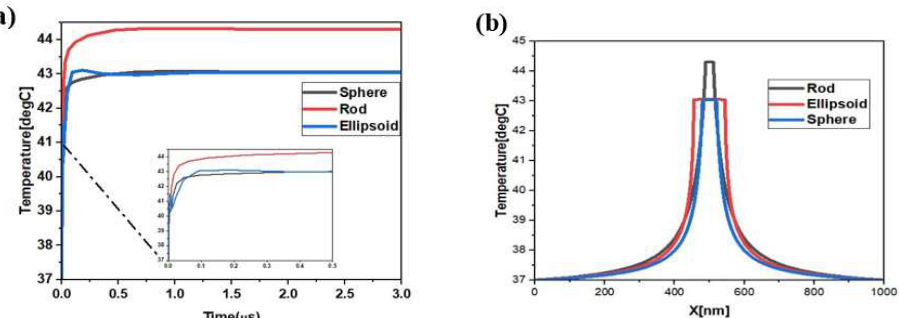
Figure 7. The time-dependent and radial–temporal distribution for three different shapes: ( a ) temperature evolution at the center of tumor (x = 0) and ( b ) the radial distribution after 3 µs of heating process. The hyperthermia process can be related to the functionality of core–shell structures.